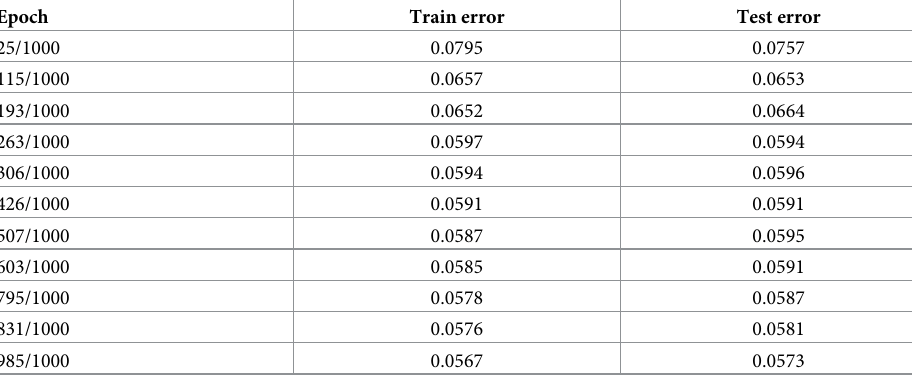
Table 16. RMSE per epoch for the optimised DNN